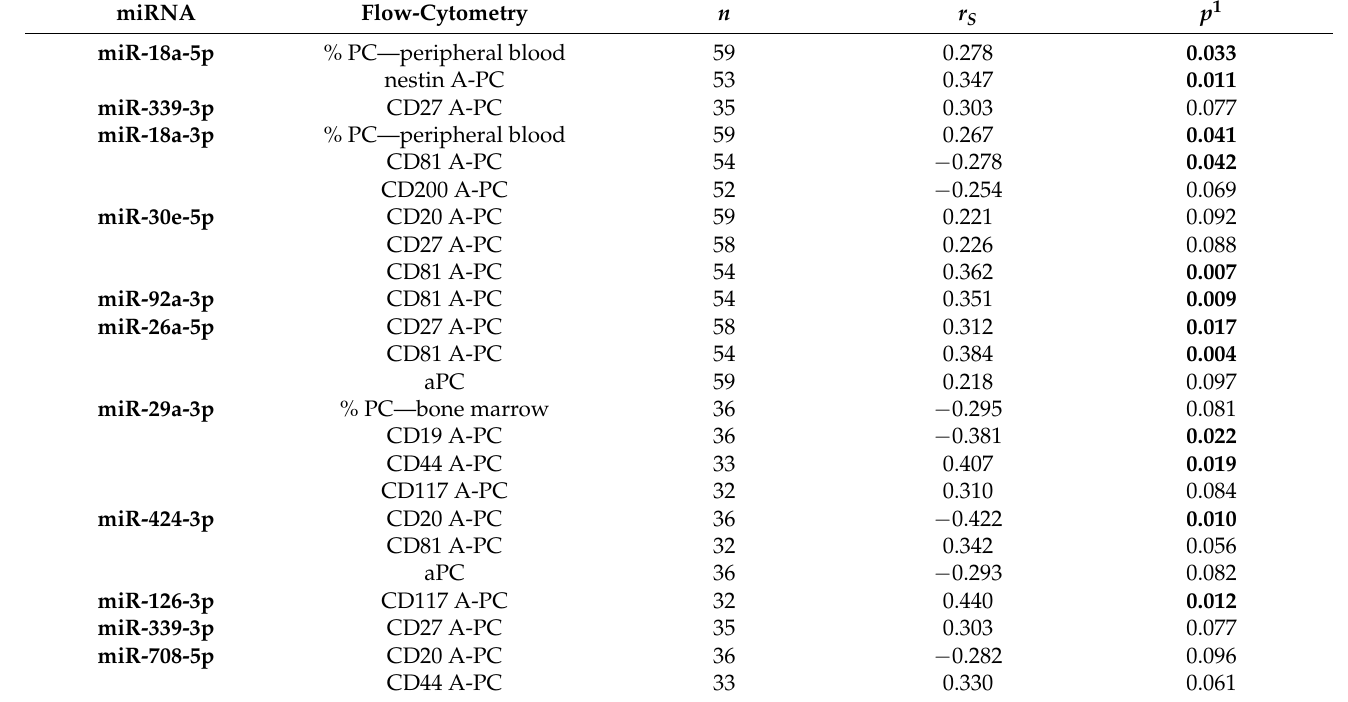
Table 4. Correlation of microRNA (miRNA) quantity and flow cytometry